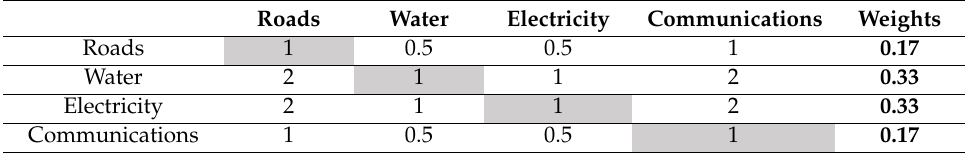
Table 11. Comparison matrix and significance weight of sub- criteria of